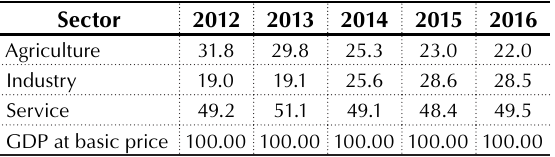
Table 1. Various SMEs sector contributions to GDP in Ghana Source: Ghana Statistical Service